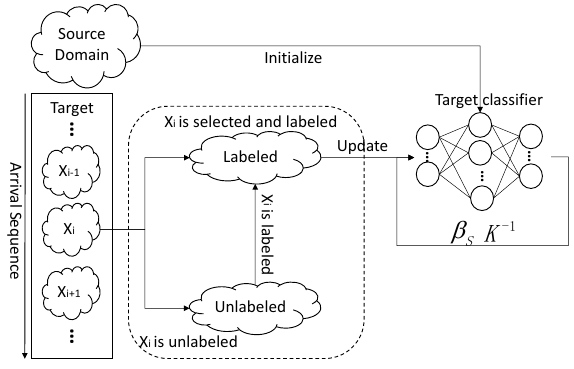
Figure 2. Online updating framework of